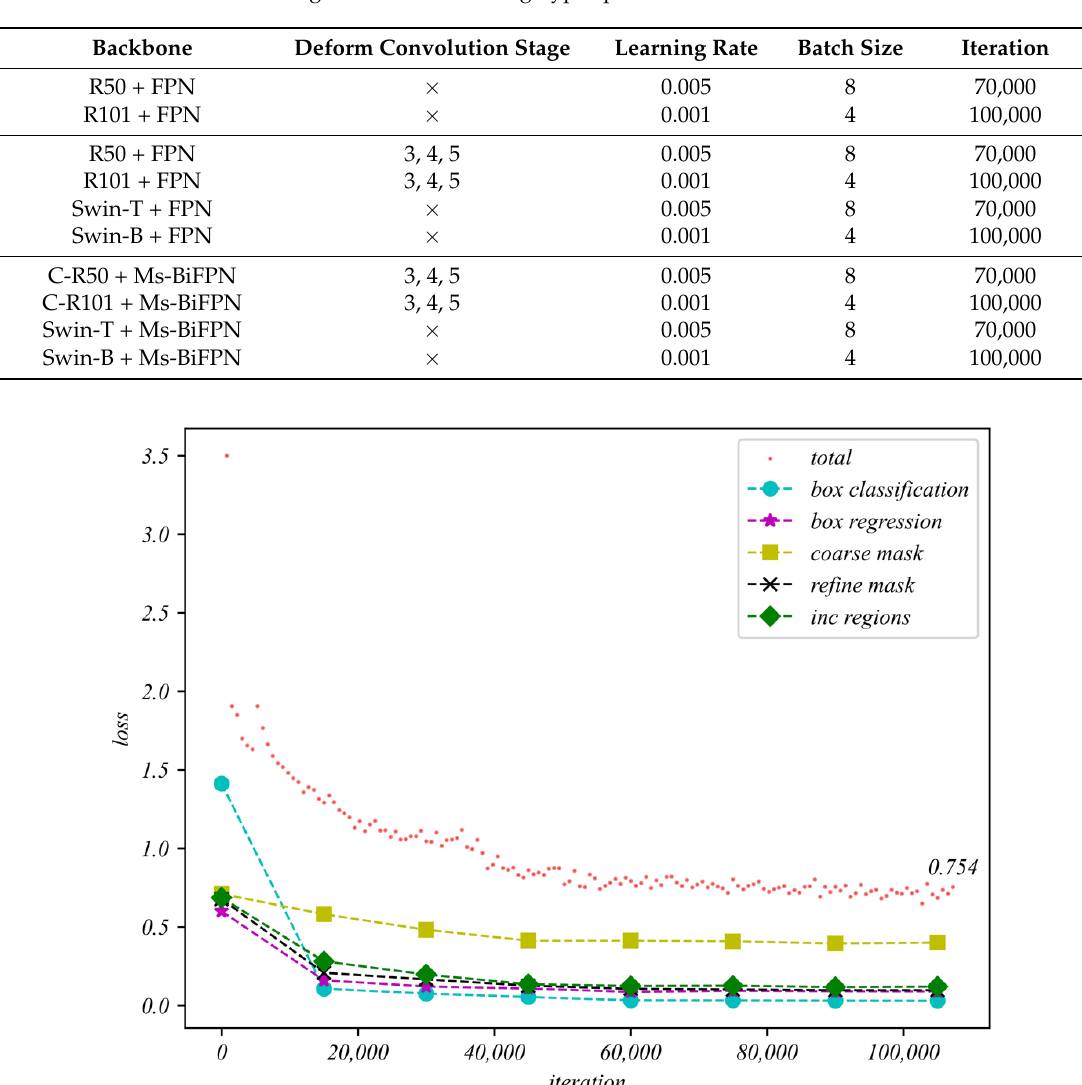
Figure 13. The loss in the training phase based on the AlgaeFiner with C-R101 + Ms-BiFPN.